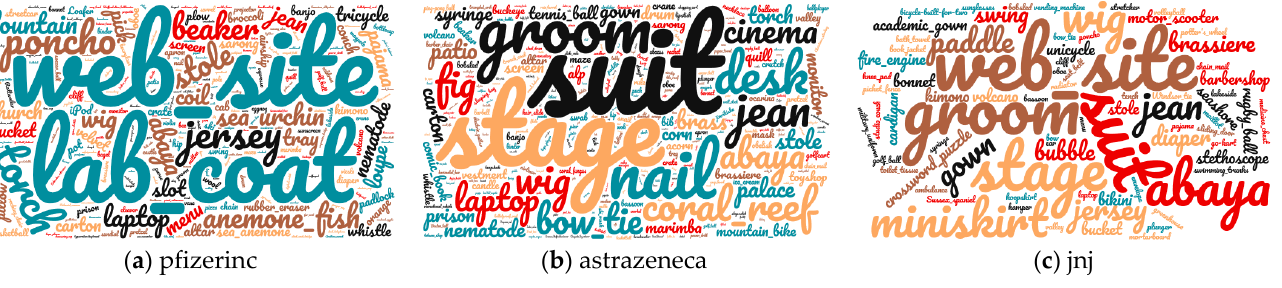
Figure 4. Word clouds for pfizerinc (a), astrazeneca (b) and jnj (c) profiles.